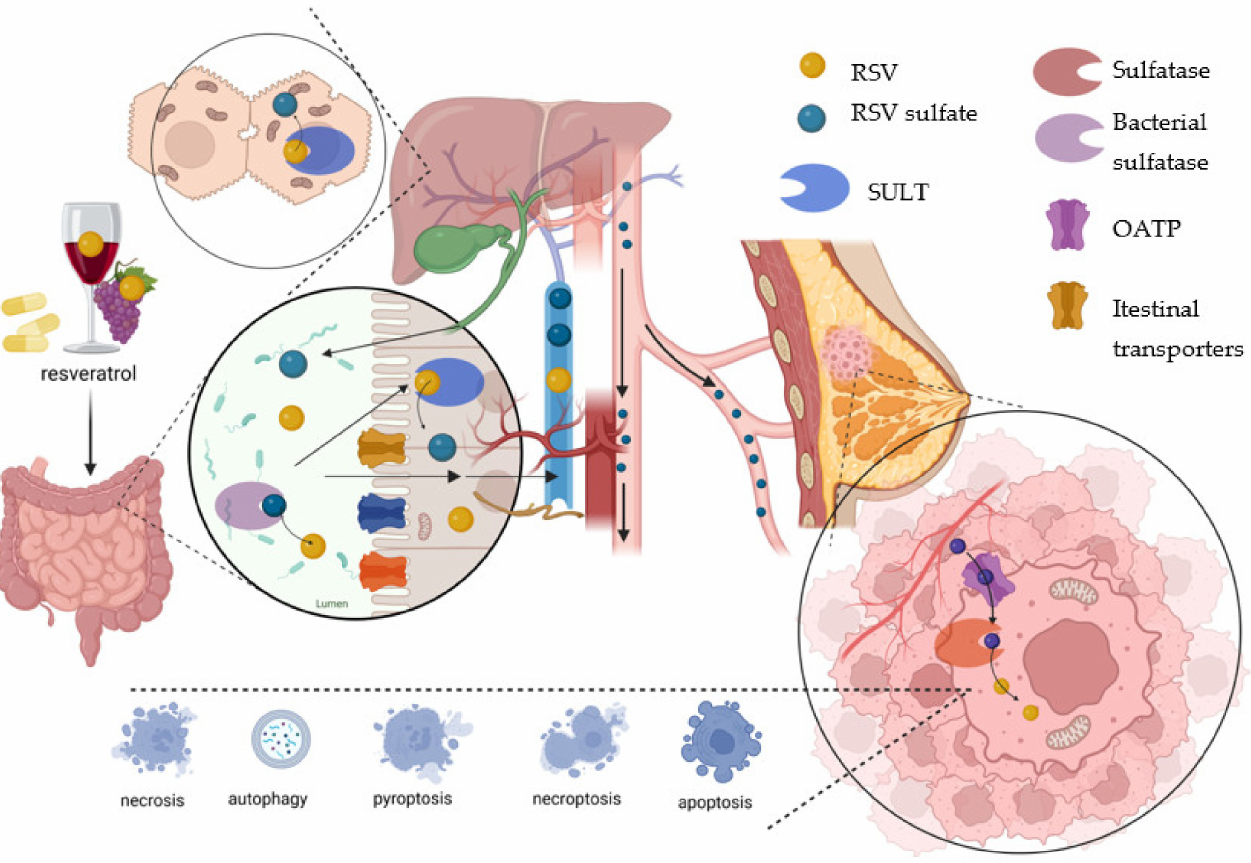
Figure 6. Long and turbulent journey of resveratrol from the ingestion to the gastrointestinal tract, via the gut wall, following sulfation and glucuronidation to the bloodstream. First-pass effect in the liver (sulfation and glucuronidation) and transport to organs, tissues, and cell uptake is possible. For instance, in breast cancer cells, OATP carriages resveratrol sulfate to cancer cells, while cleavage by sulfatases is possible. In this process, native resveratrol is released and may exert its anticancer effect inducing cell death (apoptosis, autophagy pyroptosis, necroptosis, necrosis). On the other hand, the passage from the liver via bile to intestinal and cleavage resveratrol sulfate to resveratrol to resveratrol by gut microbiota is also possible. Created with